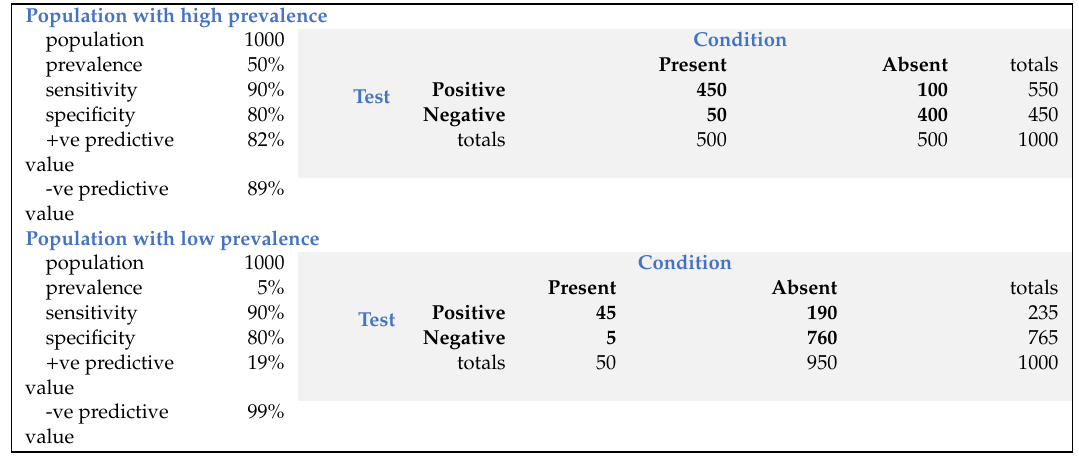
Table 3. Predictive values change with prevalence. The tables in the shaded areas are variously referred to as 2x2 tables (when the column and row totals are omitted), confusion matrices, and contingency